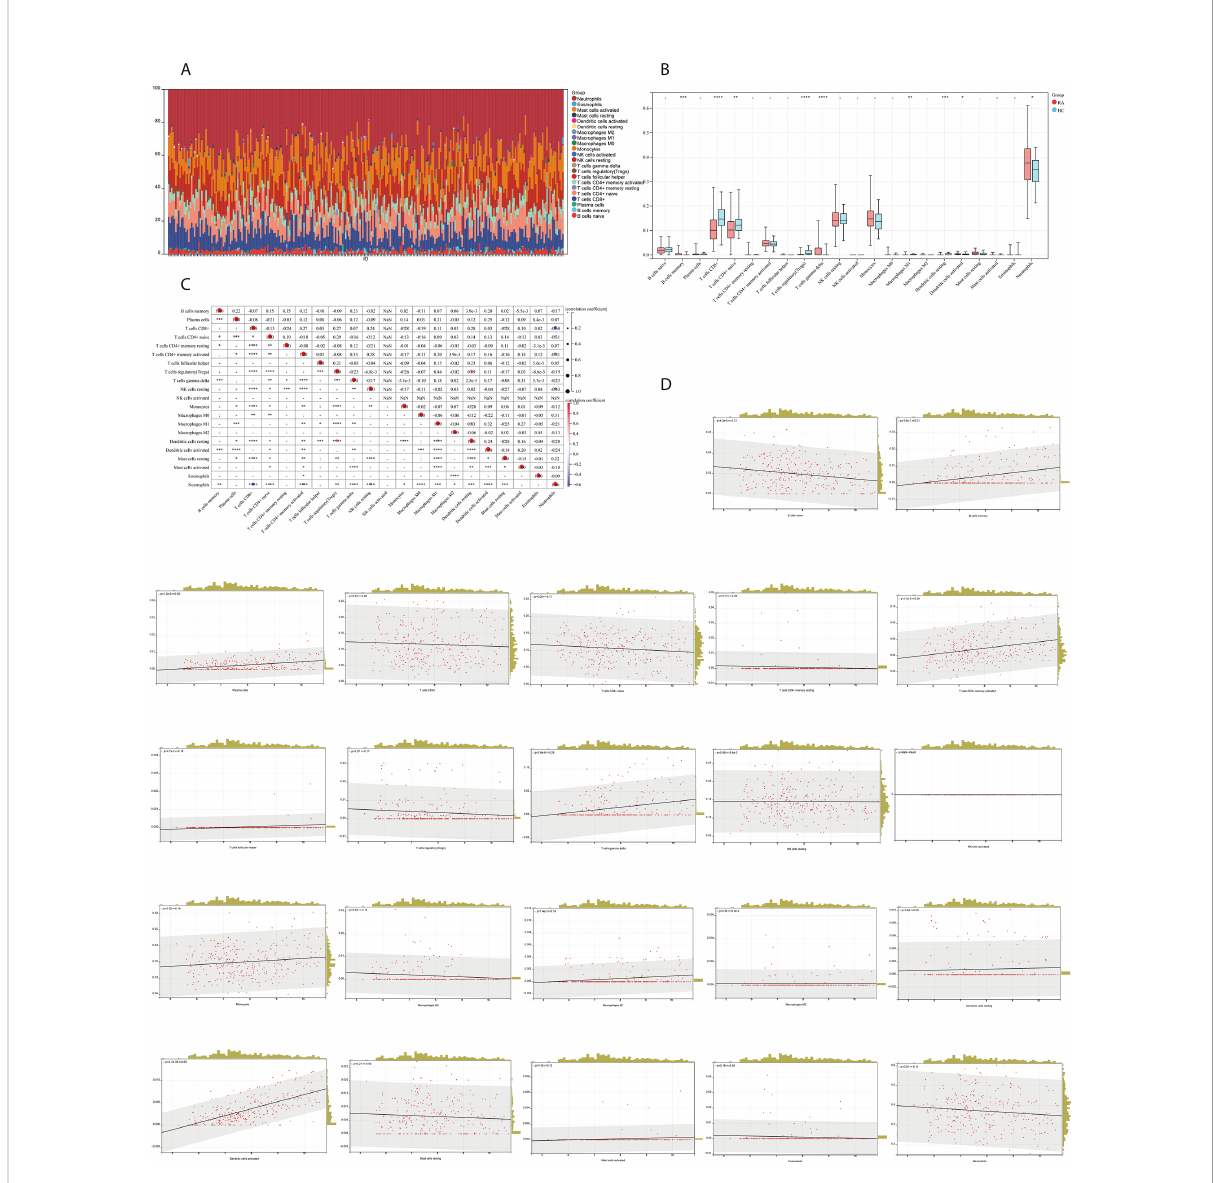
FIGURE 13 Analysis of immune cell in fi ltration. (A) A histogram of the proportion of LM22 in RA samples is depicted using the CIBERSORT algorithm, with the horizontal coordinate representing the sample and the vertical coordinate representing the percentage of individual immune cells. (B) Comparison of immune in fi ltrating cells between the RA and HC groups; red represents RA and cyan represents HC. (C) Correlation matrix between immune cells within the RA group. The horizontal and vertical coordinates are LM22, with red representing positive correlations and blue representing negative correlations (* P < 0.05, ** P < 0.01, and *** P < 0.001). (D) Correlation analysis between the expression of IFI44 and